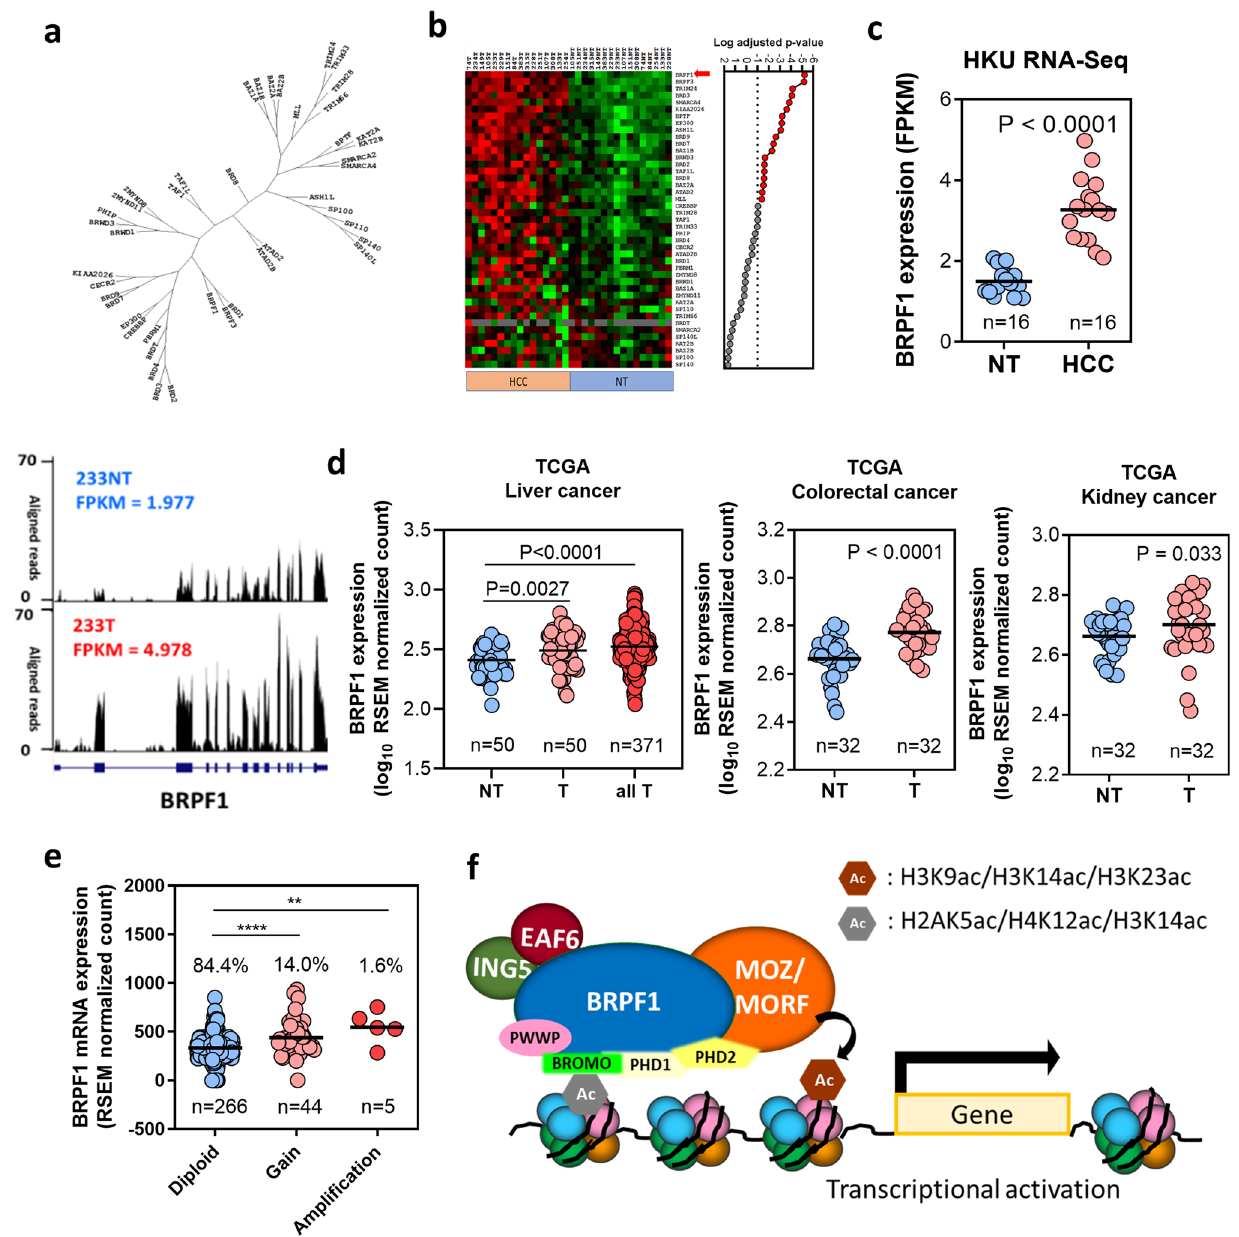
Fig. 1 Frequent upregulation of BRPF1 in human HCC. a Phylogenetic tree of 43 human bromodomain-containing genes. b The expression of 43 bromodomain-containing genes in 16 pairs of human HCC tissues and their corresponding non-tumorous liver tissues by RNA-Seq. BRPF1 is at the top of the list. The P -values were calculated by paired t -test and adjusted for multiple testing. c Bromodomain and plant homeodomain (PHD) fi nger-containing protein (BRPF1) was highly upregulated in HCC. FPKM fragments per kilobase of transcript per million mapped reads. d BRPF1 expression was signi fi cantly upregulated in TCGA liver cancer, colorectal cancer, and kidney cancer cohorts. The P -values were calculated by paired t -test. T paired tumor, NT non- tumor samples, all T unpaired and paired tumors, RSEM RNA sequencing by expectation maximization. e BRPF1 gene copy number gain and gene ampli fi cation were associated with increased BRPF1 mRNA expression in TCGA HCC cohort. The percentages in the graph represent the proportion of each condition among all tumors. f BRPF1 is a core subunit of the MOZ/MORF histone acetyltransferase complex, which mediates H3K9, H3K14, and H3K23 acetylation for gene activation. The BRPF1 protein possesses a unique combination of reader domains, which are a double PHD and zinc fi nger module (PZP), a bromodomain and a C-terminal PWWP domain. All data were compared by independent t -test unless indicated otherwise. ** P < 0.01, **** P < 0.0001 vs. diploid as